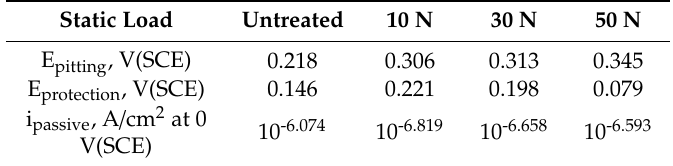
Figure 11. The effect of the static load in UNSM treatment on the polarization curve of Alloy 600 in deaerated 1% NaCl at 30 °C. Table 3. Corrosion factors obtained from Figure 10 by the static load in UNSM treatment.